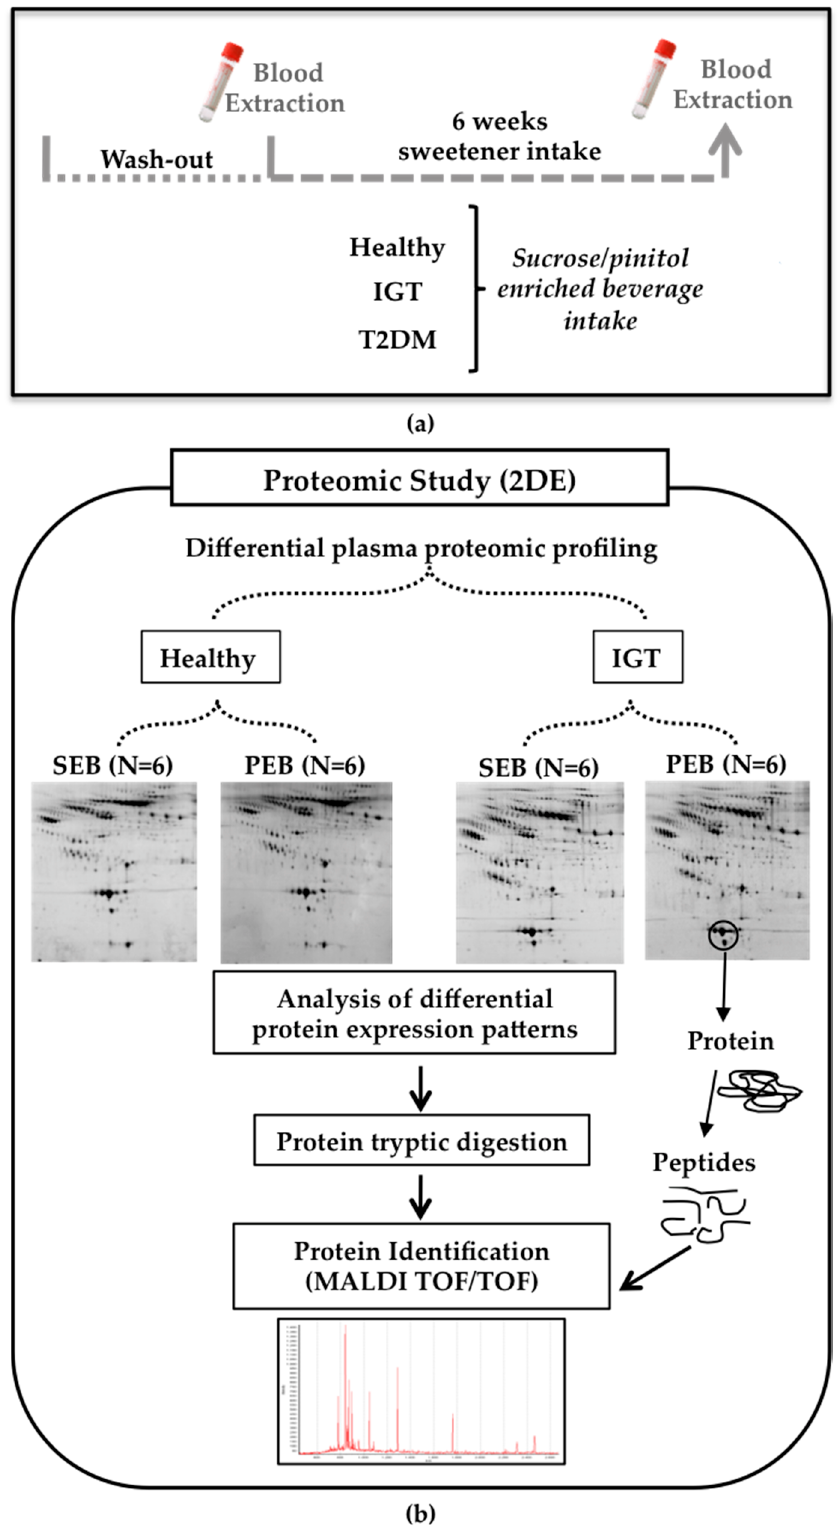
Figure 1. Human study design ( a ) Blood samples were obtained before and after six weeks of daily sucrose/pinitol-enriched beverage supplementation; ( b ) Study workflow . A proteomic approach was used to identify changes in the proteomic profile of the different plasma fractions of healthy and impaired glucose tolerance (IGT) volunteers after the intake of the sucrose/pinitol-enriched beverage ( N = 6 each group).